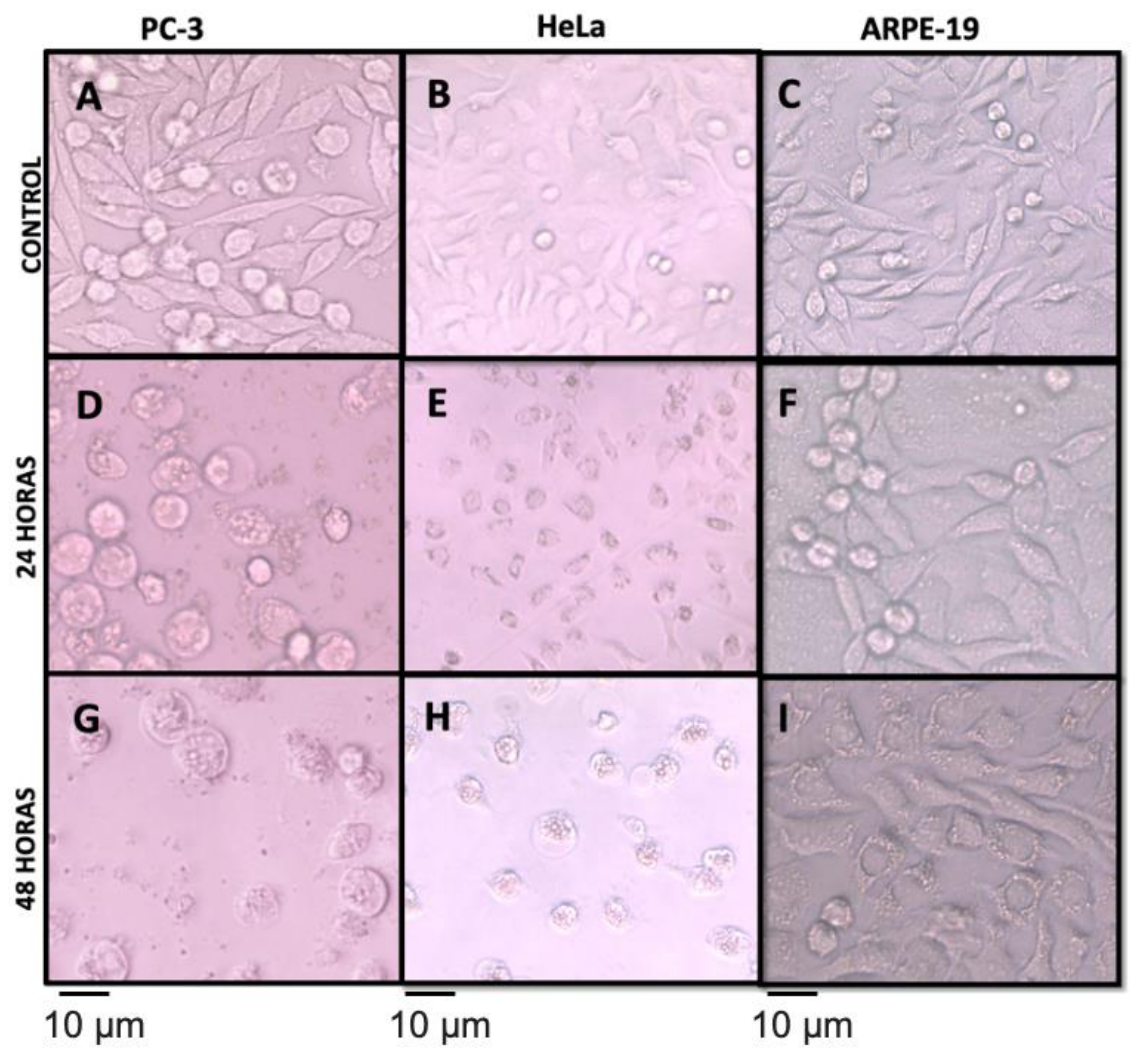
Figure 5. Effect of the different extracts obtained from N. incerta on the cell viability of A549, HeLa, and ARPE-19 cell lines during 48 h at a concentration of 200 µ g · mL − 1 . Cells with nuclear/condensed chromatin fragmentation, apoptotic bodies, and “ bleb ” membranes are appreciated. Micrograph at × 50. Cell viability of PC-3 ( A ), HeLa ( B ), and ARPE-19 ( C ) at 0 h culture time (Control). Cell viability of PC-3 ( D ), HeLa ( E ), and ARPE-19 ( F ) at 24 h culture time. Cell viability of PC-3 ( G ), HeLa ( H ), and ARPE-19 ( I ) at 24 h culture time. The bar represents a scale of 5 μm.